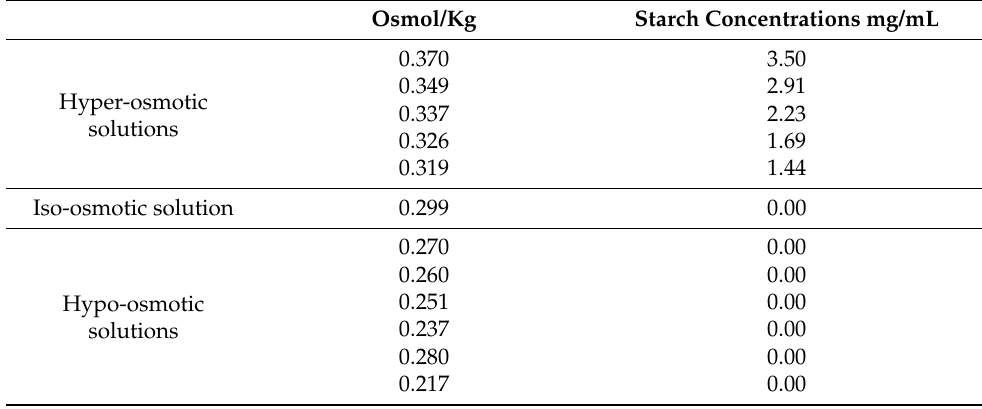
Table 1. Osmolality values of 5 different hyper-osmotic solutions and 6 different hypo-osmotic solutions. Hyperosmotic solutions were prepared by adding starch to a PBS solution. Hypo-osmotic solutions were prepared adding purified water to a PBS